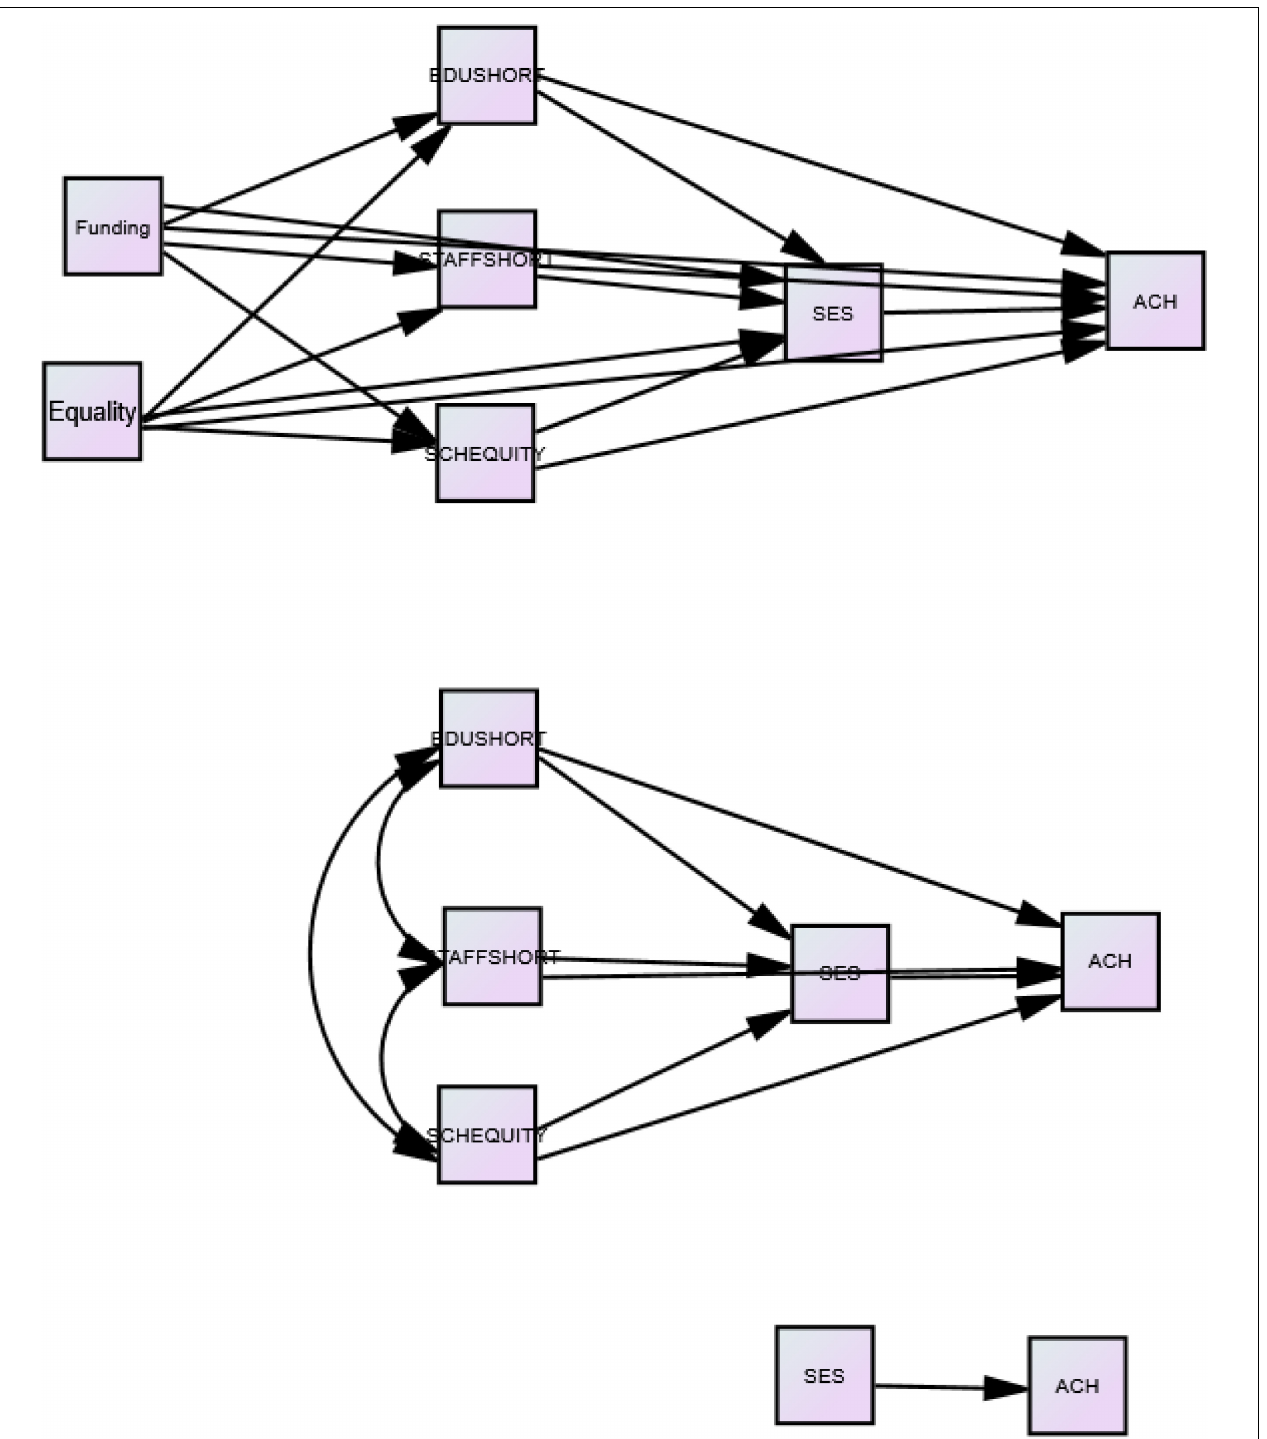
FIGURE 2 | Partial mediation model.